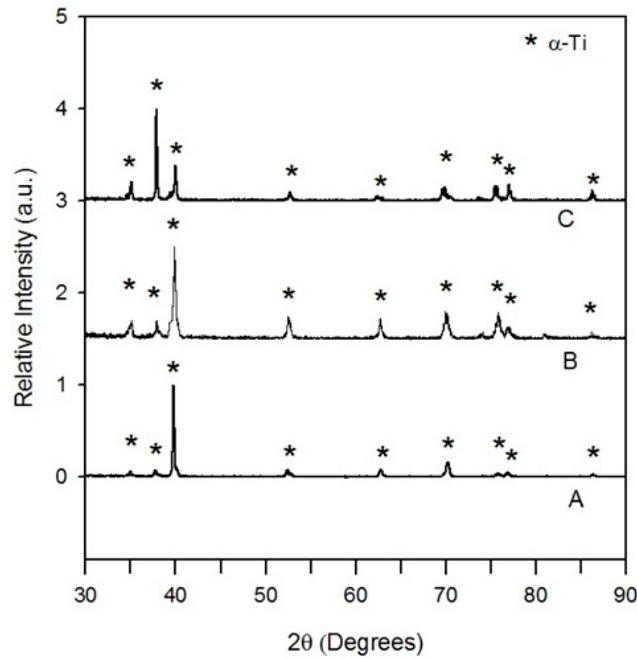
Figure 5. X-ray diffraction patterns of manufactured Ti foams. A: 55.9% porosity, B: 68.4% porosity, and C: 78.0% porosity.